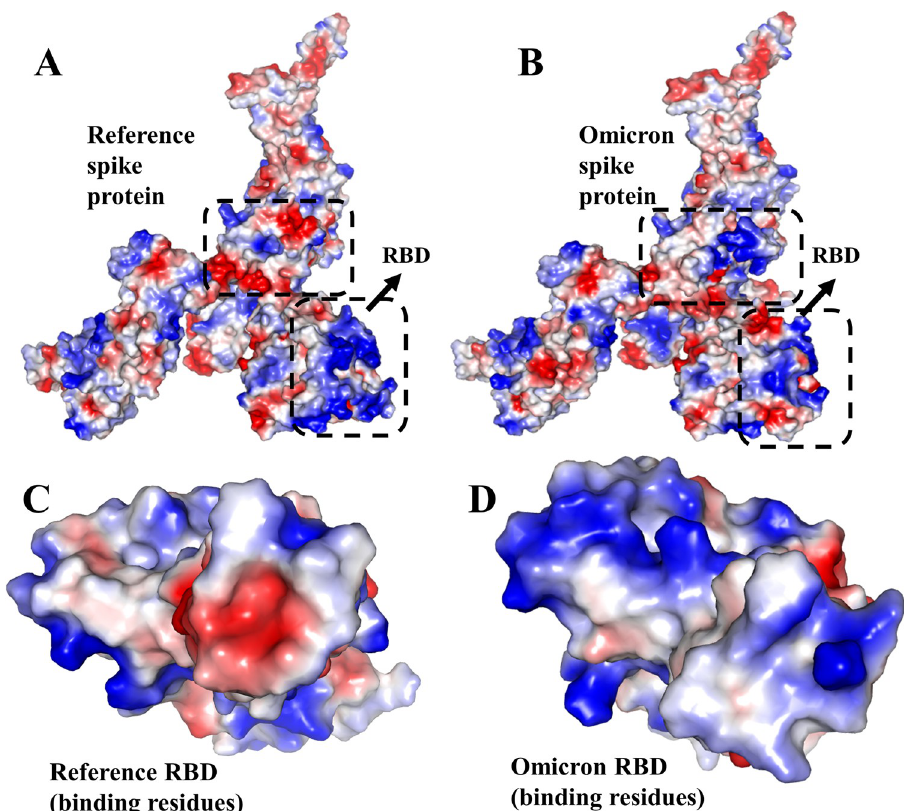
Fig 3. The electrostatic surface of the spike protein. The red and blue colors denote negative and positive potential respectively. Due to mutations at residues near the receptor recognition site, their electrostatic potential shifts from negative to positive, predicted to facilitate the binding with hACE2. A. Electrostatic potential map for the whole reference spike protein, B. Overall electrostatic potential map of the whole Omicron variant spike protein, C. High electronegativity of the recognition site at RBD of reference variant, D. Low electronegativity of the recognition site at RBD of Omicron variant.